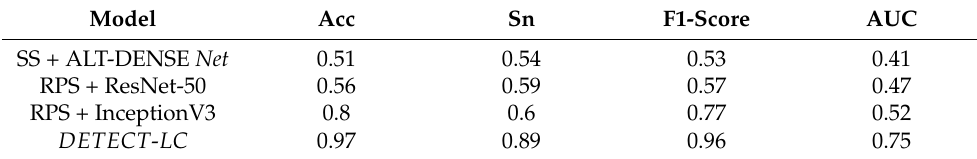
Table 8. Lung Cancer Staging Performance Evaluation on NSCLC Radiomics (Lung 1).